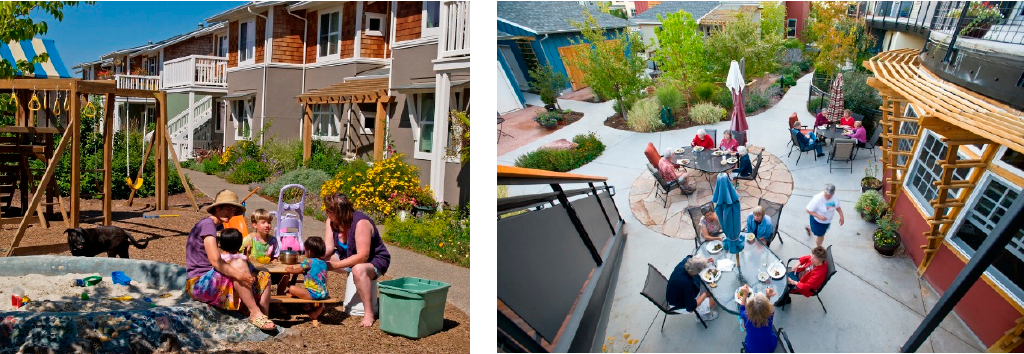
Figure 7. Co-housing project in the USA [30].